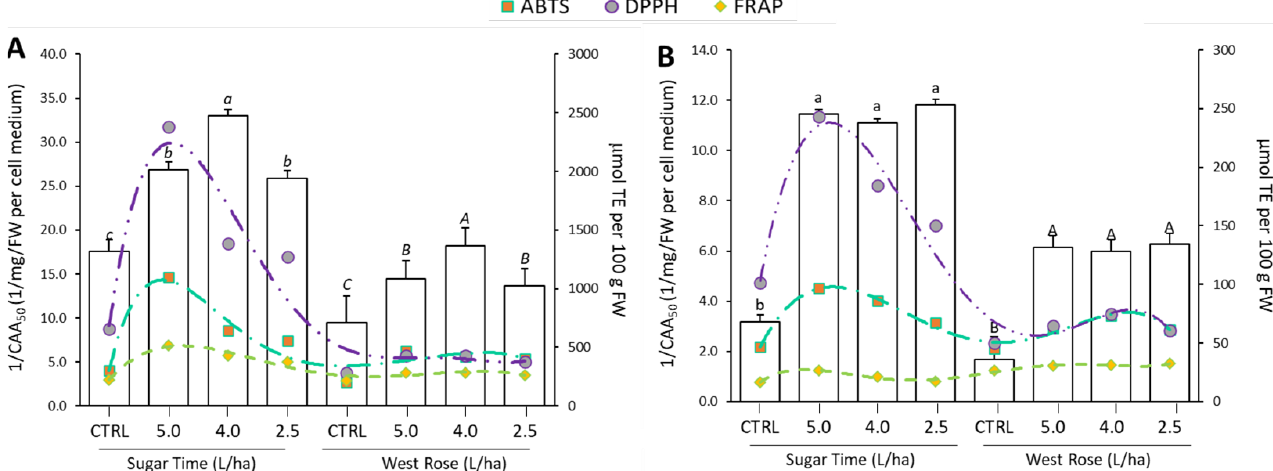
Figure 6. Antioxidant activities of ethanolic extracts from the pulp ( A ) and peel ( B ) from peaches harvested from Prunus persica trees var. “Sugar Time” and “West Rose” after treatment with different concentrations (2.5, 4.0 or 5.0 L/ha) of biostimulant or with water alone. In the different panels, CTRL identifies samples harvested from trees treated with water only. The histograms show the cellular antioxidant activity (CAA) expressed as 1/CAA 50 , while the dashed lines indicate the radical scavenging activity (dark green: ABTS; purple: DPPH) or reducing metal (light green: FRAP) measured as µ mol TE per 100 g of FW. Within the same series, different lowercase (var. Sugar Time) or uppercase (var. West Rose) letters indicate significant difference at the p ≤ 0.05 level as measured by one-way ANOVA followed by Tukey’s multiple range test.